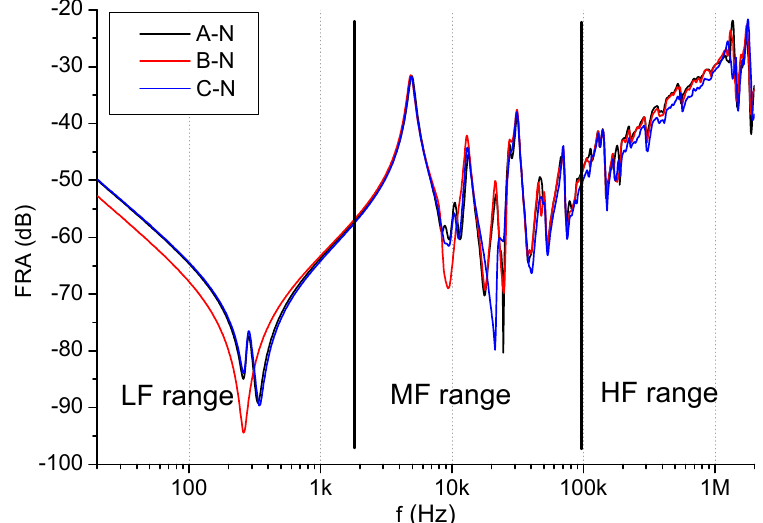
Figure 2. Example of frequency response amplitude curves of a three-phase transformer, measured in end-to-end open test setup, presented in a logarithmic scale. Three frequency ranges are marked.